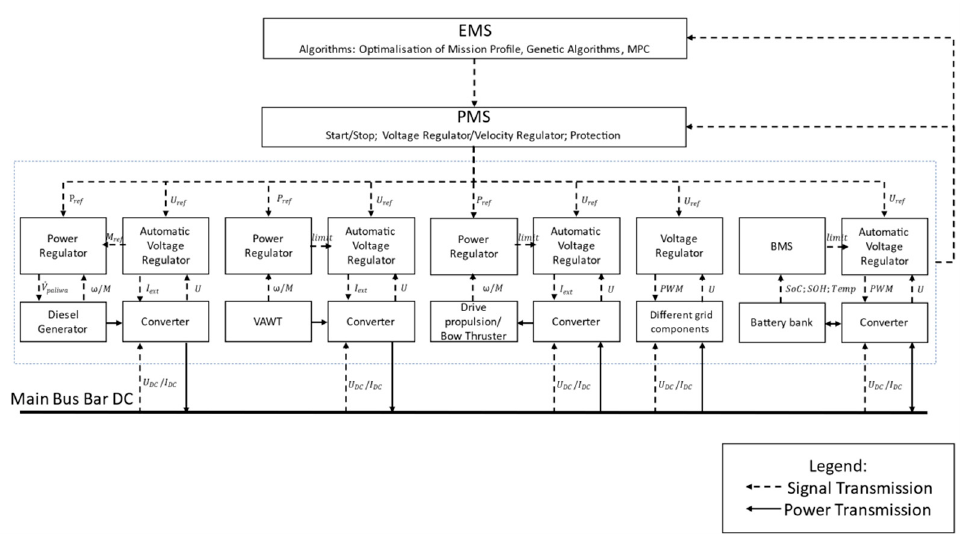
Figure 4. The concept of the topology of the onboard grid.